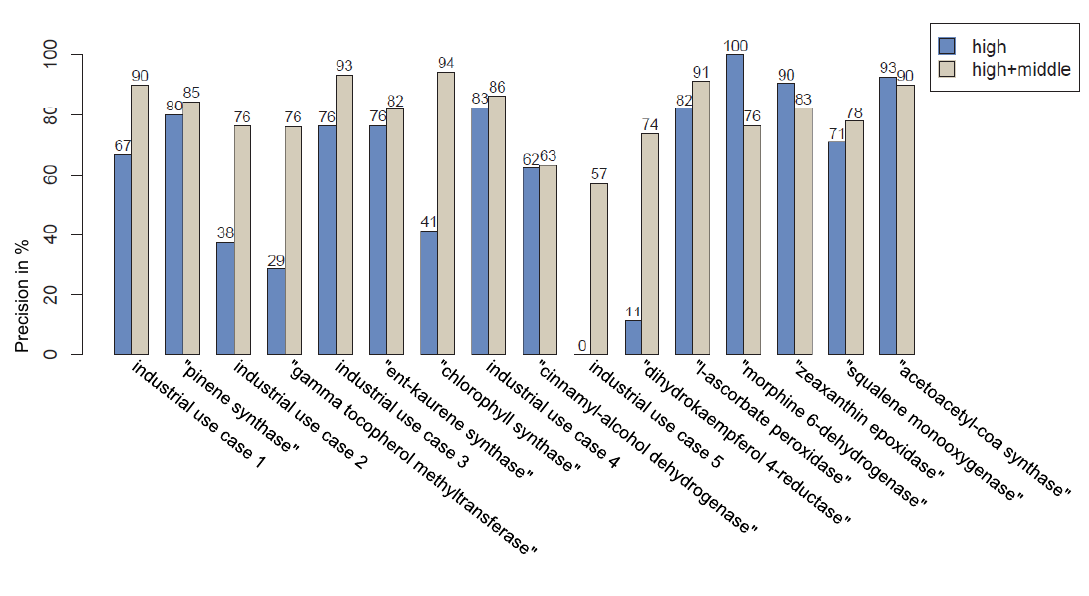
Figure 5: LAILAPS recall for use case queries